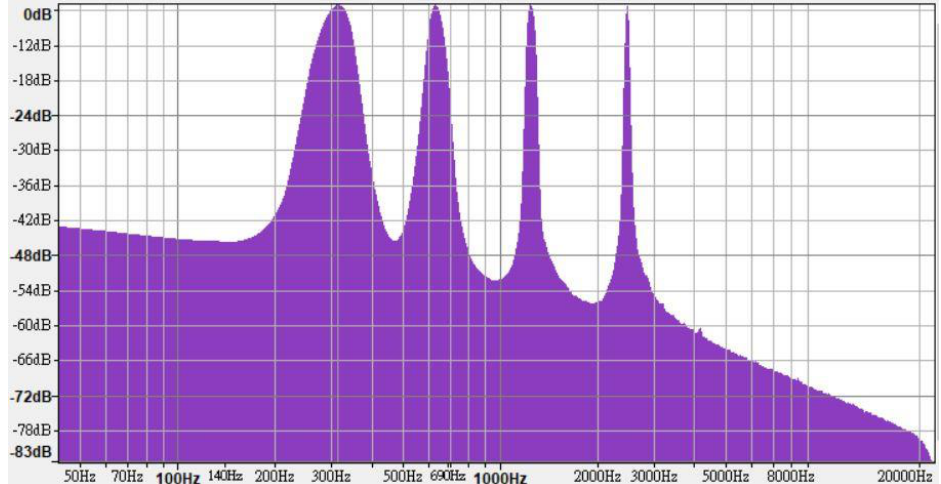
Figure 3. Frequency characteristics of medium-frequency warning sound.